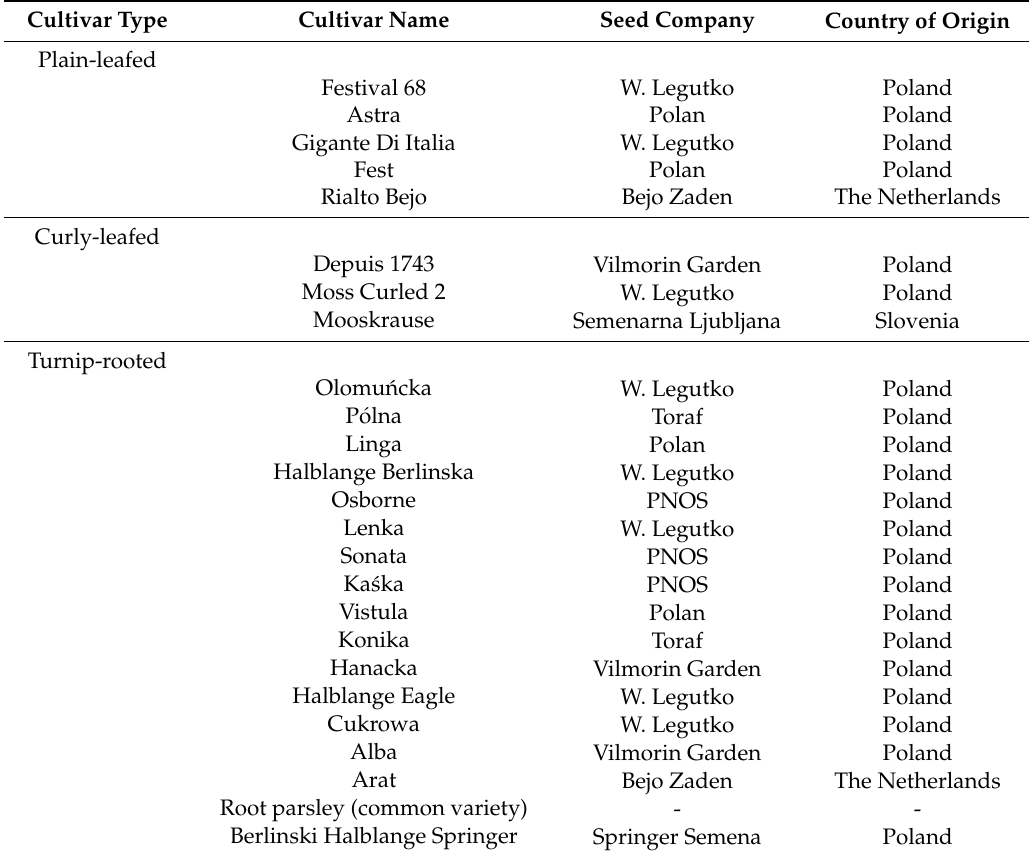
Table 6. List of cultivars used in the present experiment (type and name of cultivar and seed company). Cultivar